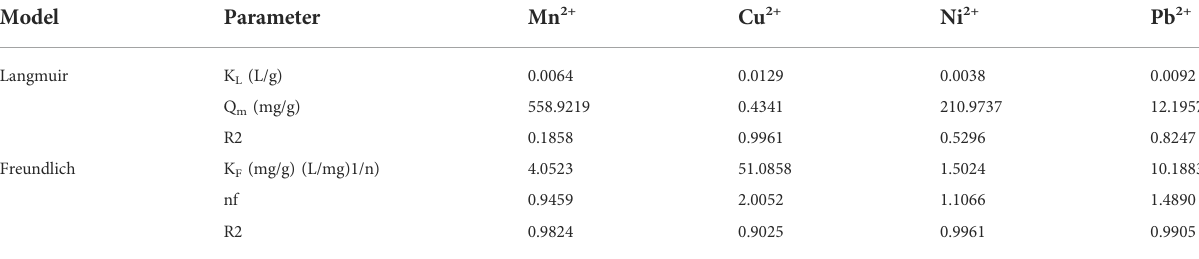
TABLE 3 Langmuir and Freundlich isotherm parameters of adsorption of four HMs by MCFA.